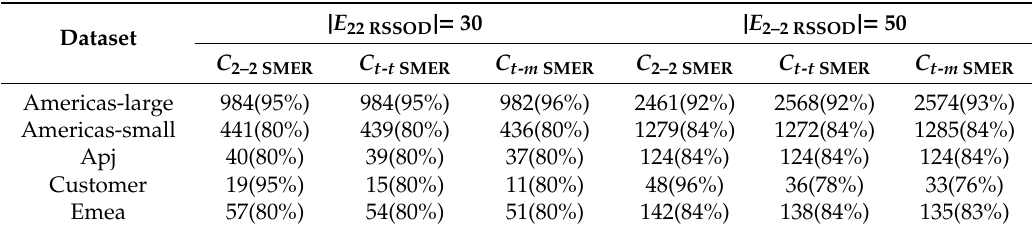
Table 7. Results of SMER constructed from 2–2